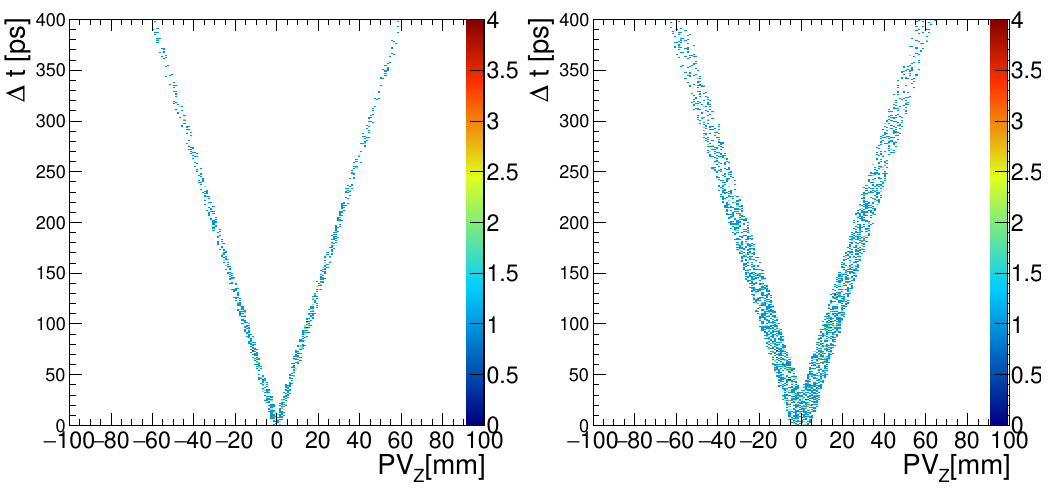
Figure 4 . Absolute time of (cid:13)ight di(cid:11)erence of two protons detected in the timing FDs versus PV position in z -direction, considering 10 ps (left) and 30 ps (right) resolutions. This correlation is calculated for the SM process pp ! p W + W (cid:0) (cid:13)